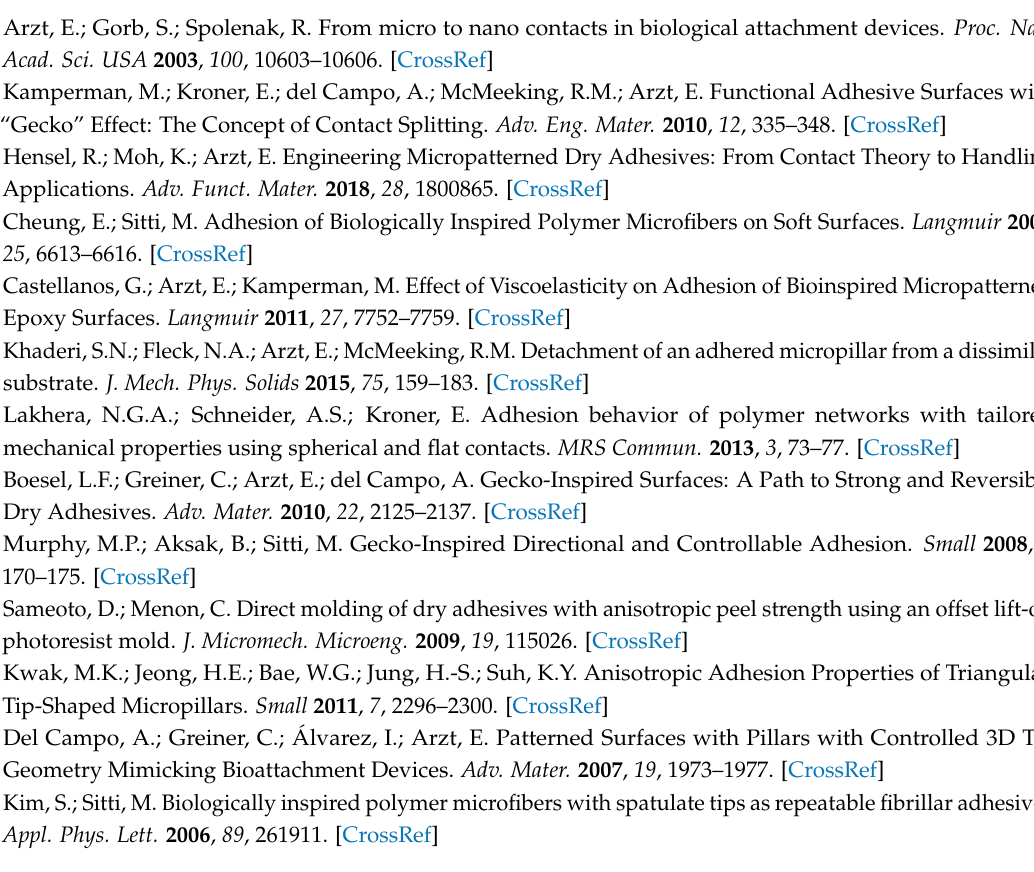
Figure S1: (a) Illustration of adhesion test device. (b) Force-displacement curve from a normal adhesion test with a spherical glass probe; Table S1: Surface free energy of UA16 and ePDMS as determined by contact angle (CA)